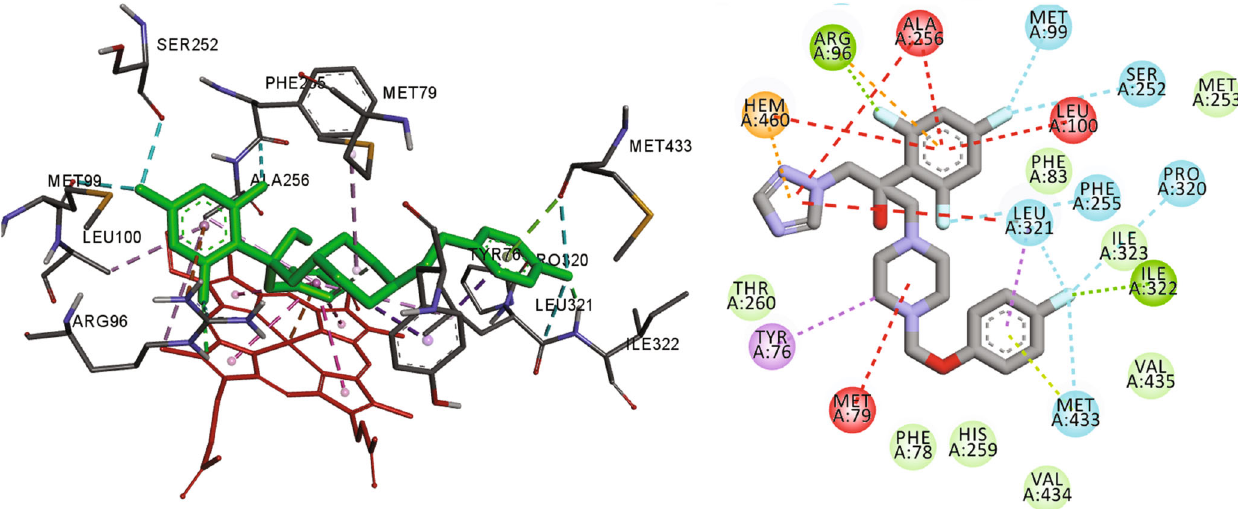
Figure 5: 2D and 3D interactions of F13 in cytochrome P bond, pale green: van der Waals, orange: pi-cation, red: pi-alkyl).